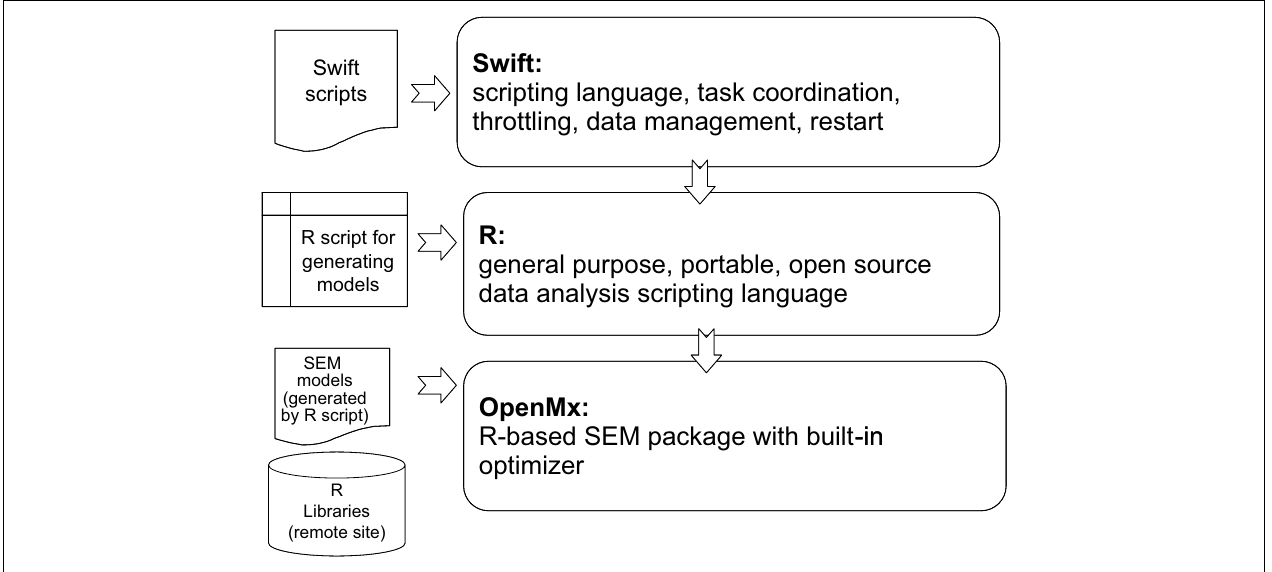
FIGURE 1 | User Interface: Overview of the CNARI scripting modules for SEM workfl